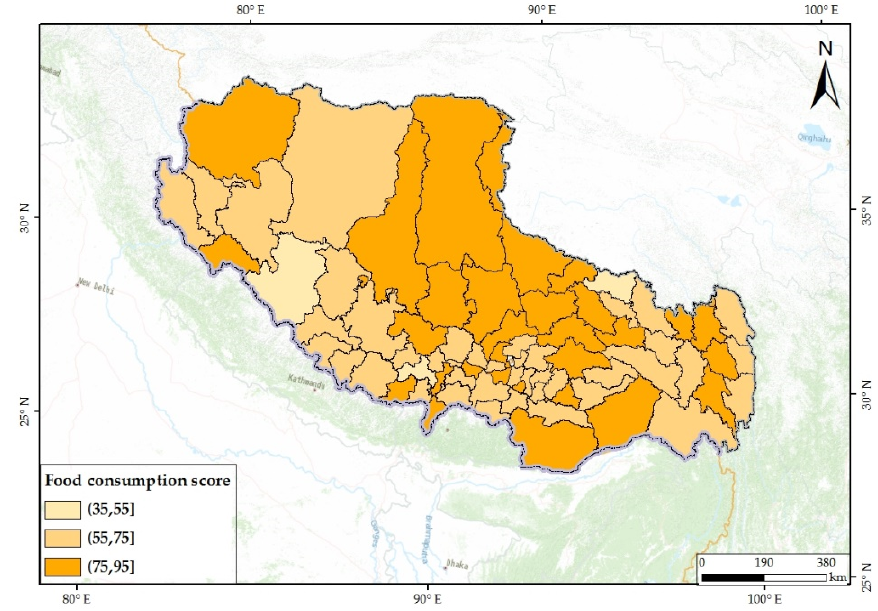
Figure 5. Mean value of food consumption score of subjects in counties.